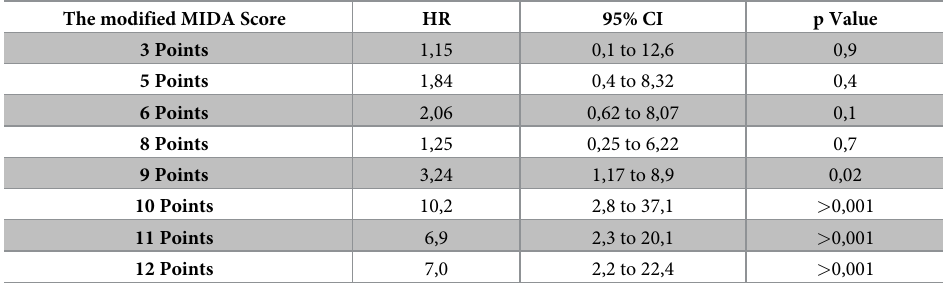
Table 6. Risk stratification of the modified MIDA Score concerning the combined endpoint: A detailed list with point distribution using the cox proportional hazards regression analysis. The modified MIDA